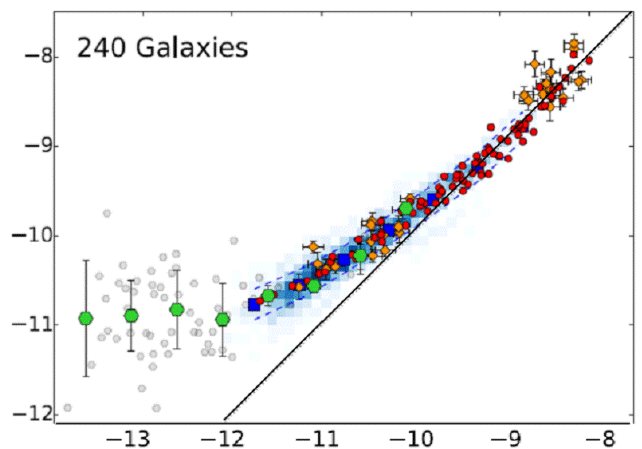
Figure 4. The observed acceleration (vertical axis) as a function of the expected one from the distribution of baryons (horizontal axis) for 240 galaxies [34,35]. Logarithmic scales along both axes. Colored dots correspond to galaxies of di ff erent morphological types. The straight 1:1 line shows where the observed and the expected Newtonian accelerations would coincide without dark matter.